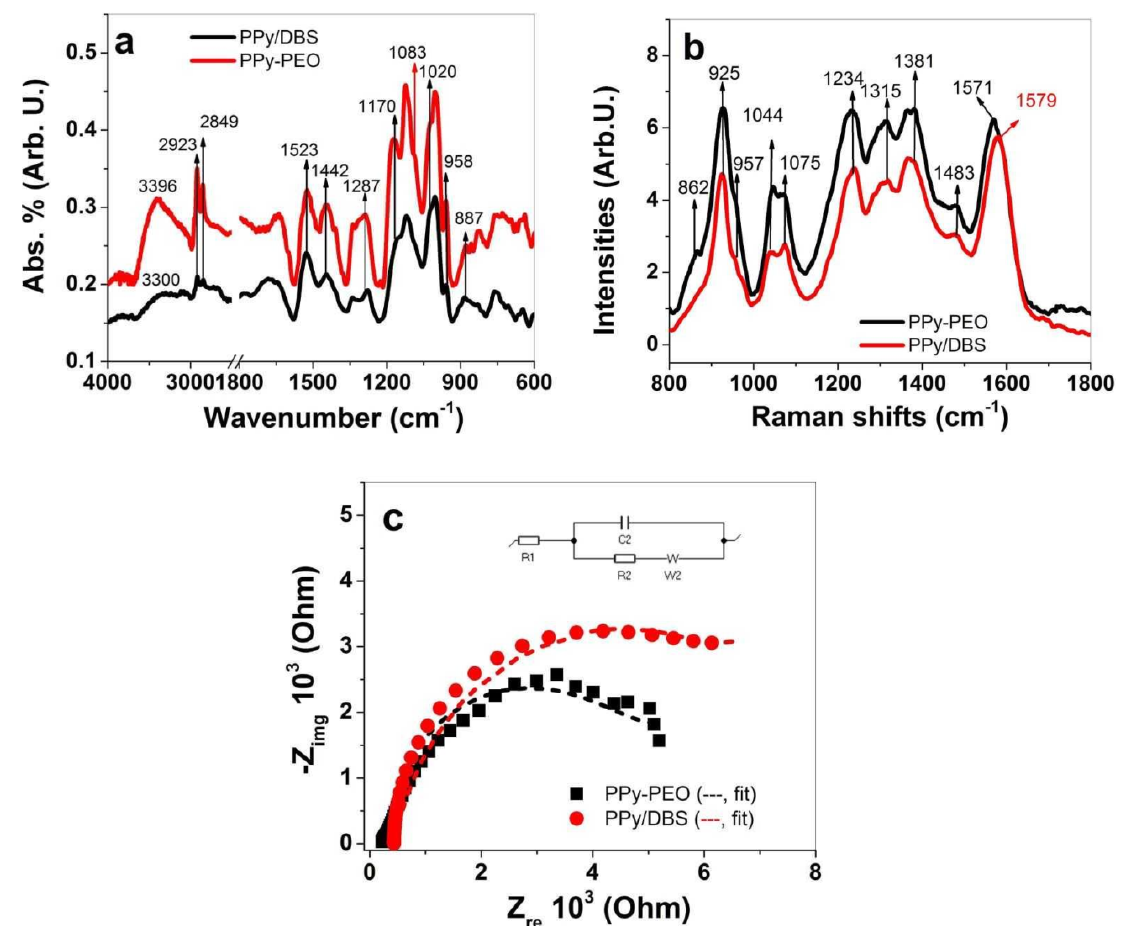
Figure 2. FTIR spectroscopy (4000 − 600 cm − 1 ) of PPy-PEO (black line) and PPy/DBS (red line) is shown in ( a ) and Raman spectroscopy (785 nm, 1800–800 cm − 1 ) is presented in ( b ). The EIS measurements of PPy samples conducted in PC solvent of PPy-PEO ( (cid:4) , - - fit) and PPy/DBS ( • , - -) are shown in ( c ). The inset in ( c ) represents Randle’s equivalent circuit where R1 is the solution resistance, R2 represents the charge transfer resistance, C2 describes the double-layer capacitance and W2 is the Warburg